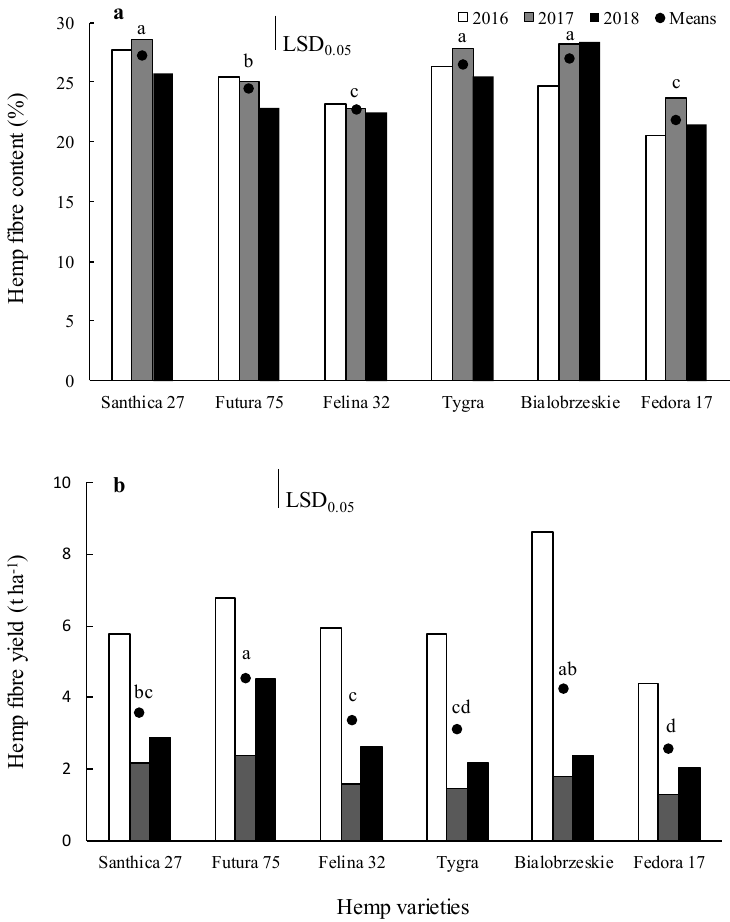
Figure 4. Fibre percentage ( a ) and fibre yield ( b ) of six industrial hemp varieties. For the year × variety interaction, columns with height differences lower than the LSD height did not significantly differ according to the Fisher’s Protected Least Significant Difference (LSD) test at p = 0.05. For the variety effect, points with the same letter did not significantly differ according to the Fisher’s Protected Least Significant Difference test at p = 0.05 .